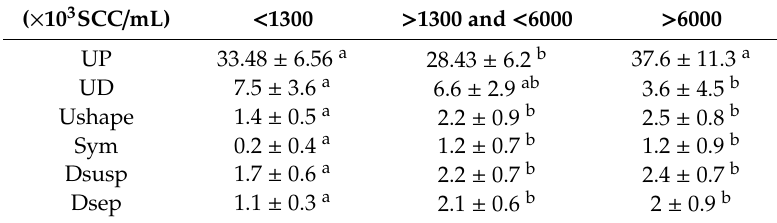
Table 4. Comparison of udder measured conformation traits (cm) and subjective parameters for SCC groups.